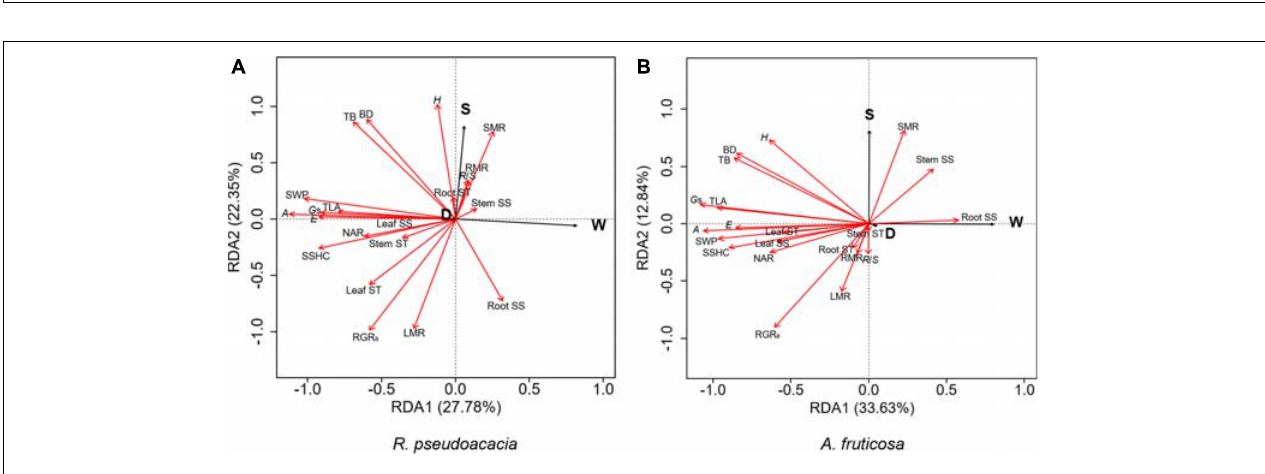
Frontiers in Plant Science |